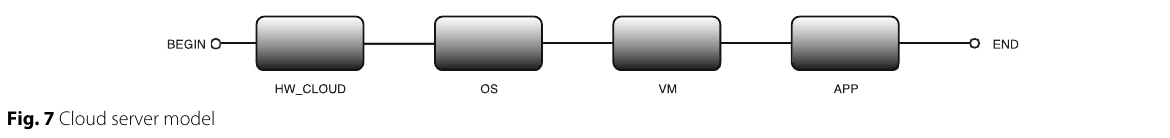
Fig. 7 Cloud server model